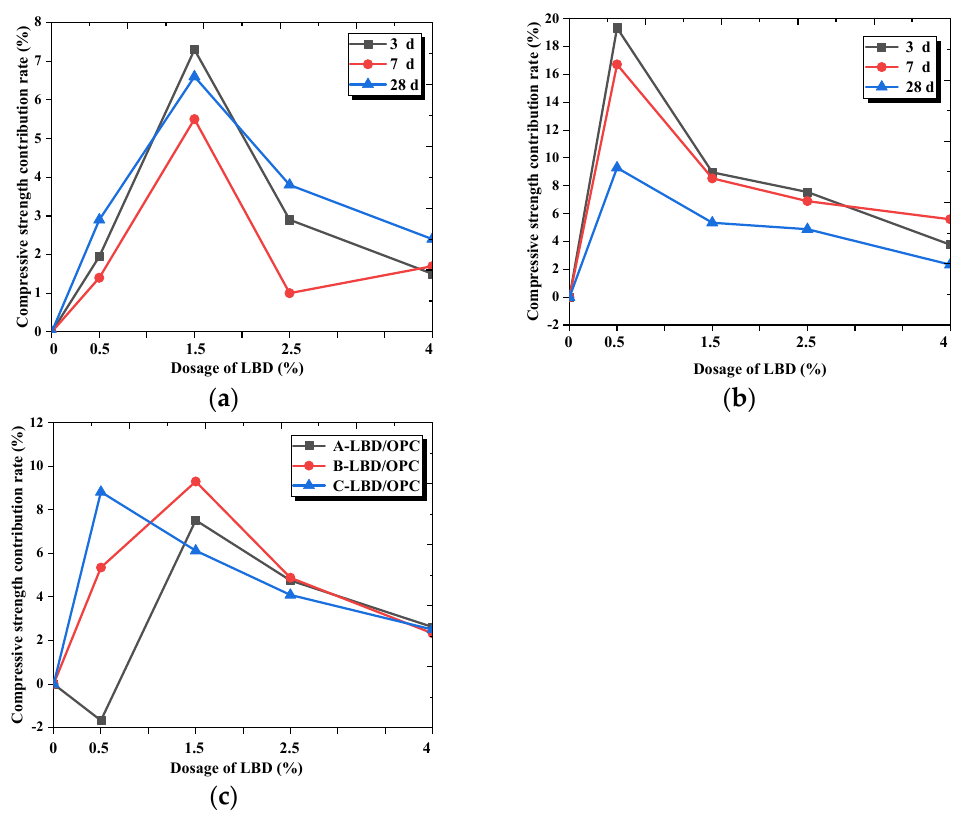
8 of 16 ( c ) Figure 5. Compressive strength of LBD/OPC samples: ( a ) A-LBD/OPC samples; ( b ) B-LBD/OPC samples; ( c ) C-LBD/OPC samples. Figure 6 shows the compressive strength contribution rate of the different dosages and fineness levels of LBD to cement-based materials. The strength contribution rate of cement-based materials was greater than 0 after adding LBD powder, besides A-